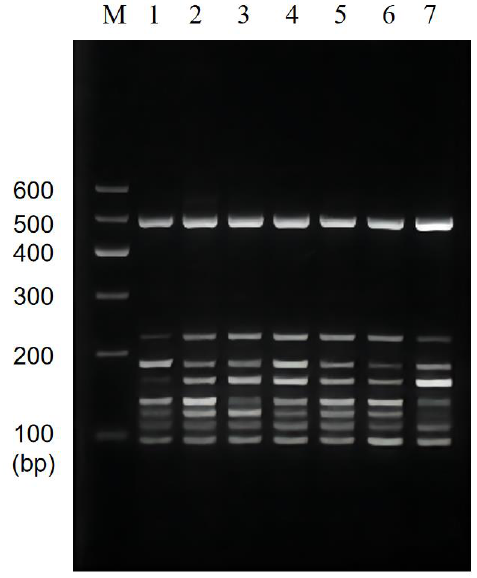
Figure 4. Results of primer ratios optimization for multiplex PCR. Lane M: DNA marker B 600; Lane 1~7: The amplification results of different primer concentration ratios. The lightest band is Lane 4, the ratio of primer of V. parahaemolyticus , L. monocytogenes , E. coli O157:H7, C. sakazakii , S. flexneri , P. putida , V. vulnificus , and V. alginolyticus is 1:2.5:1:0.5:0.5:1:1:0.5. The proportion of primers used for the rest is shown in Table 4.